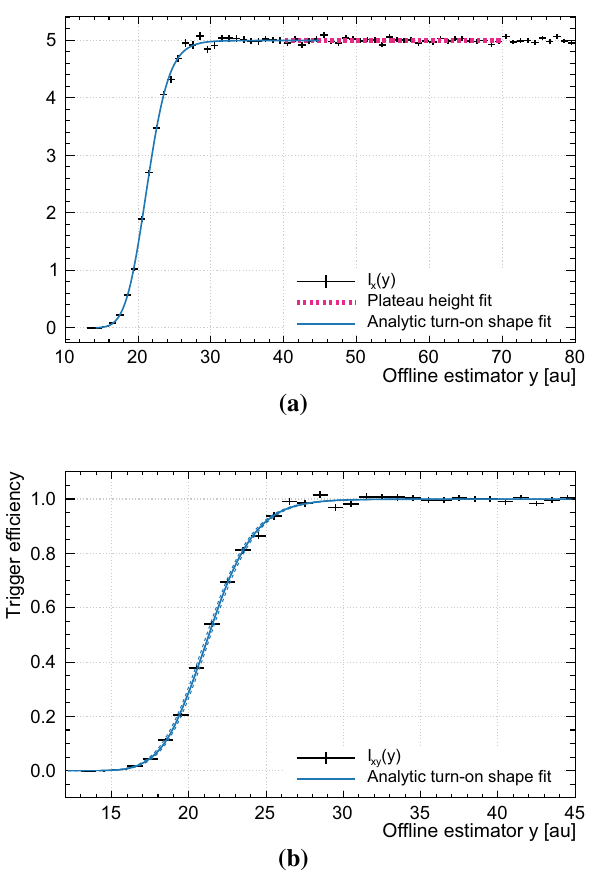
Fig. 2 For the same MC data as Fig. 1 a The I x ( y ) distribution is fit with a straight line in a region far away from the trigger threshold, and with the analytic description of the turn-on shape, which is known in this case. b I x ( y ) scaled by the plateau height results in the trigger efficiency curve (zoomed in compared to panel a) to better show the turn-on